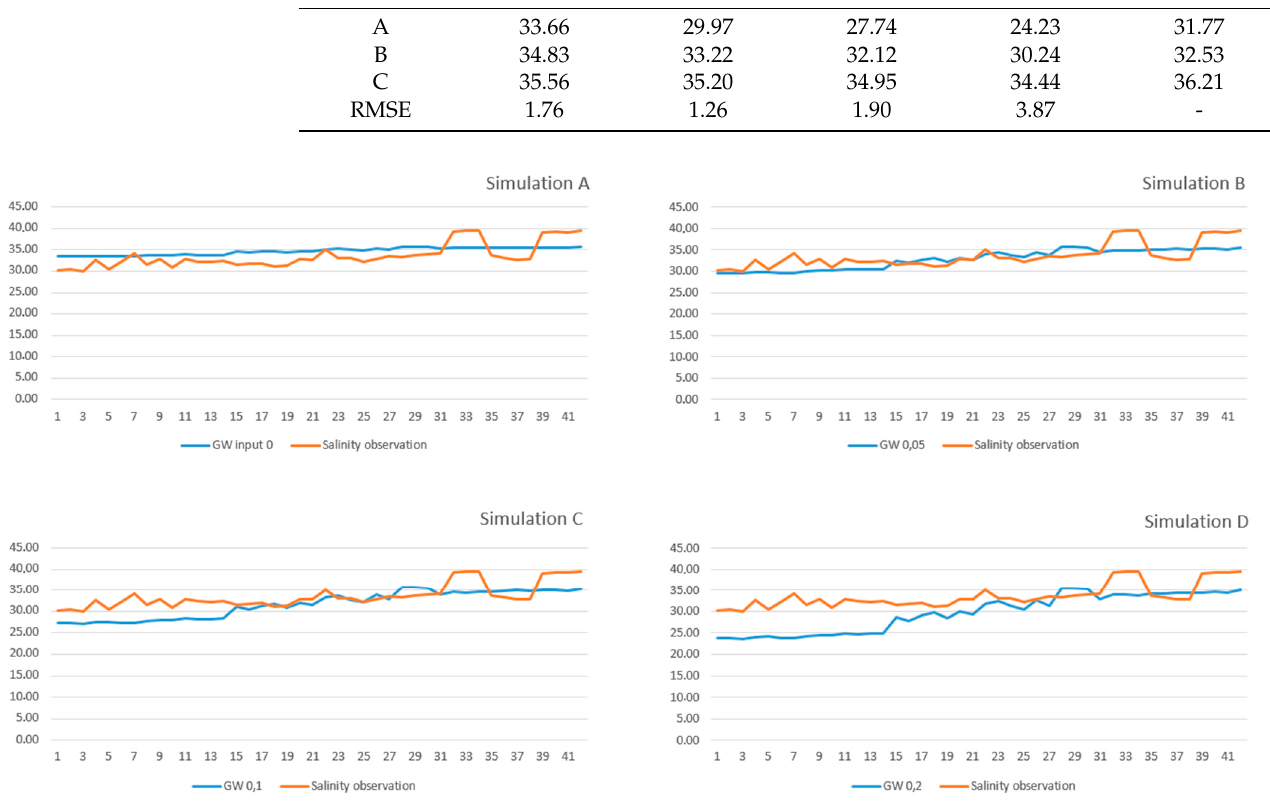
Figure 5. Modeled and observed salinity (PSU) comparison for each SGD input case (Simulation A ): 0; (Simulation B ): 0.05; (Simulation C ): 0.1; (Simulation D ): 0.2. With the x-axis representing the stations’ numbers and the y-axis representing the salinity values.